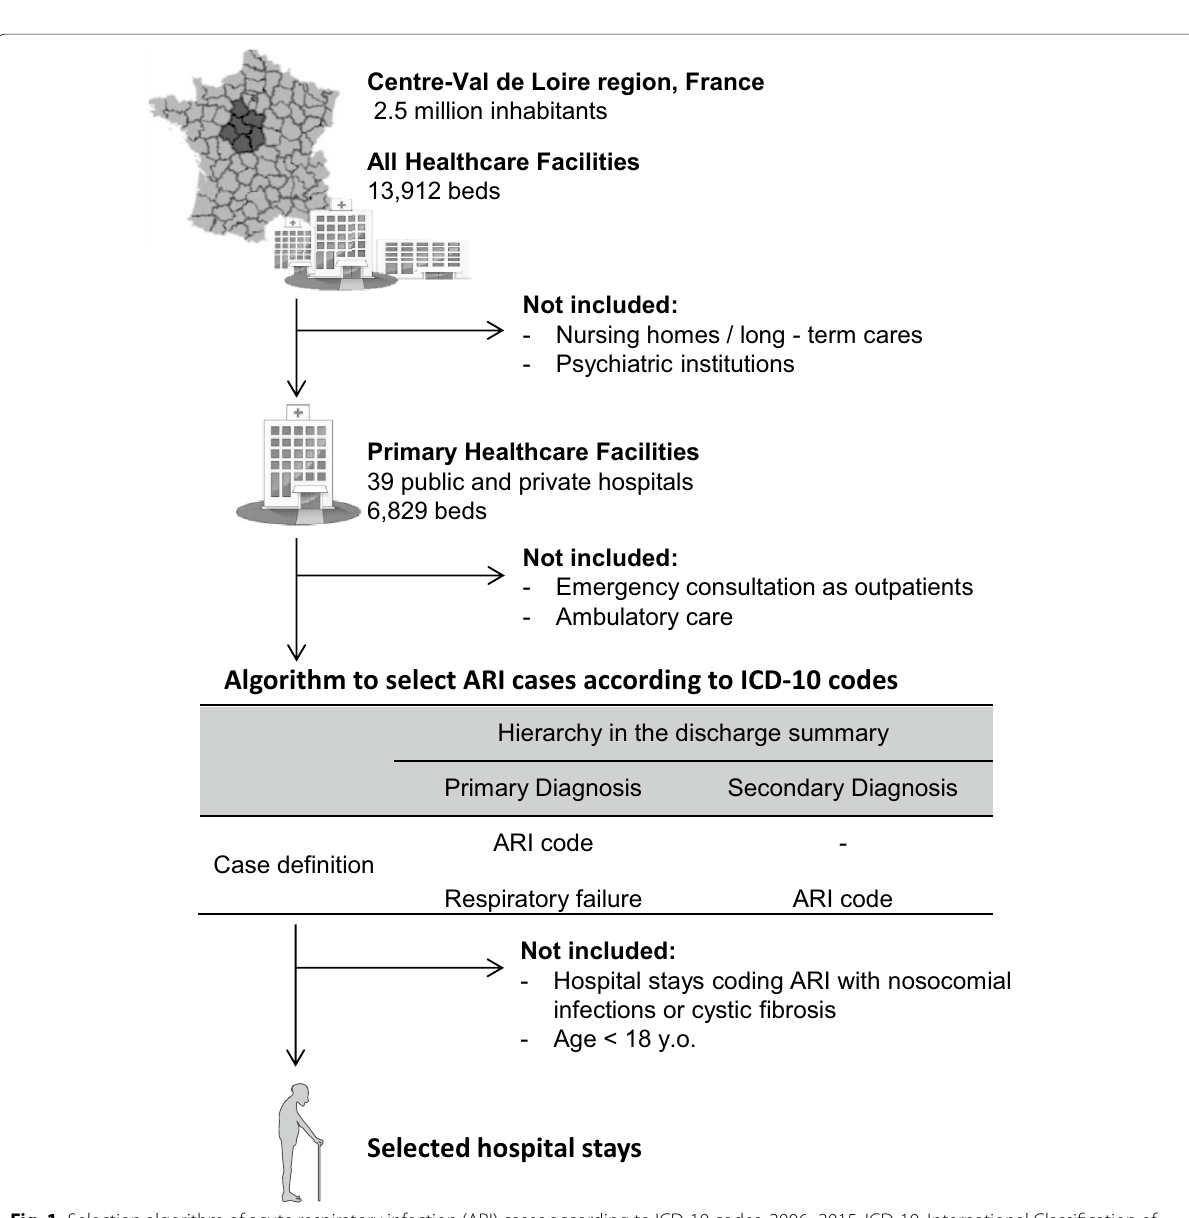
Fig. 1 Selection algorithm of acute respiratory infection (ARI) cases according to ICD‑10 codes, 2006–2015. ICD‑10: International Classification of Diseases, Tenth